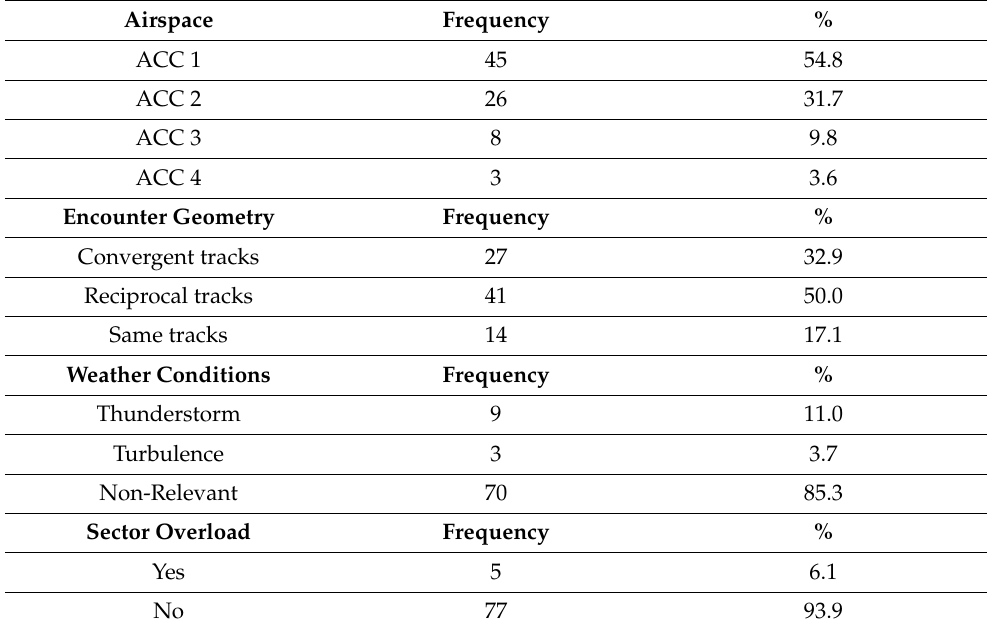
Table 2. Frequency distributions for qualitative variables which describe scenario